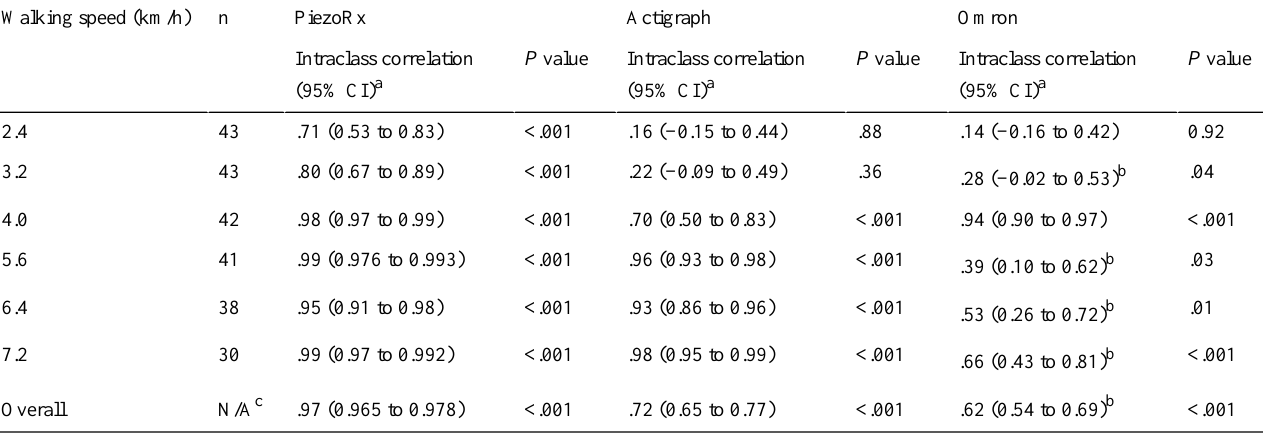
Table 2. Two-way mixed-model intraclass correlation with measure of consistency. OmronActigraphPiezoRxnWalking speed (km/h)